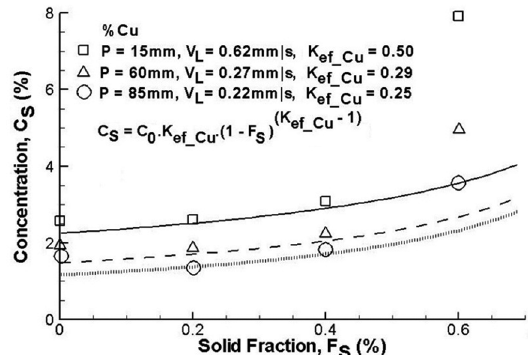
Figure 11. Microsegregation of Cu solute in the Al-9.0wt%Si- 4.0wt%Cu alloy experimentally measured and calculated via Scheil's equation using the effective partition coefficient ( K